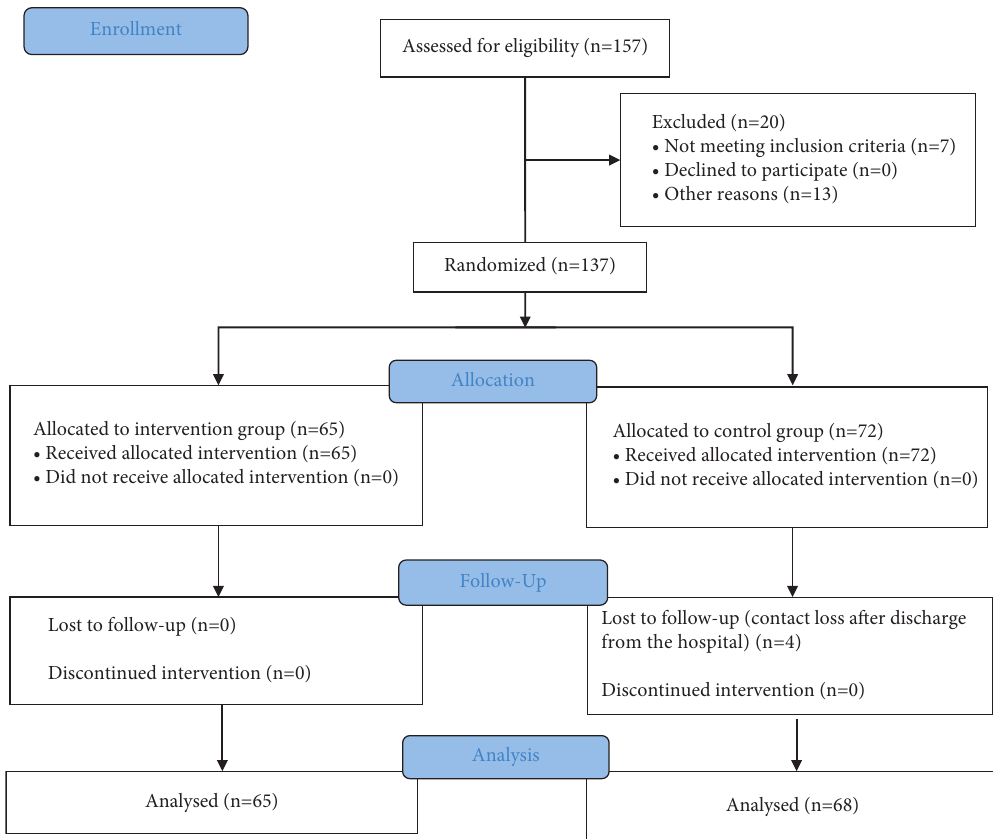
Figure 1: A flow diagram of the